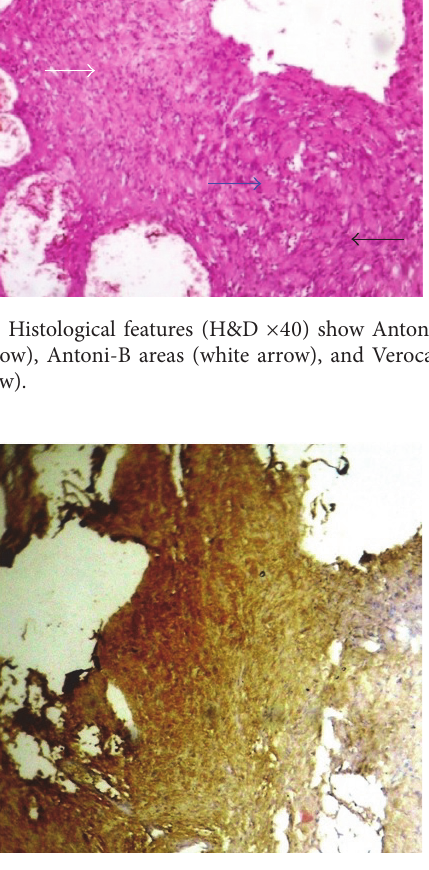
Figure 8: Immunohistochemistry ( × 40) positive for